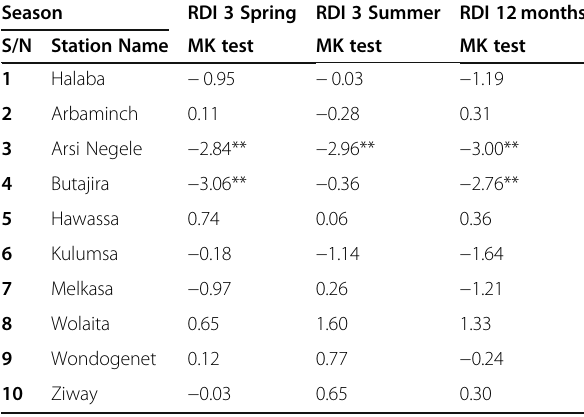
Table 3 The Mann-Kendall ’ s trend test for spring, summer and annual time scales